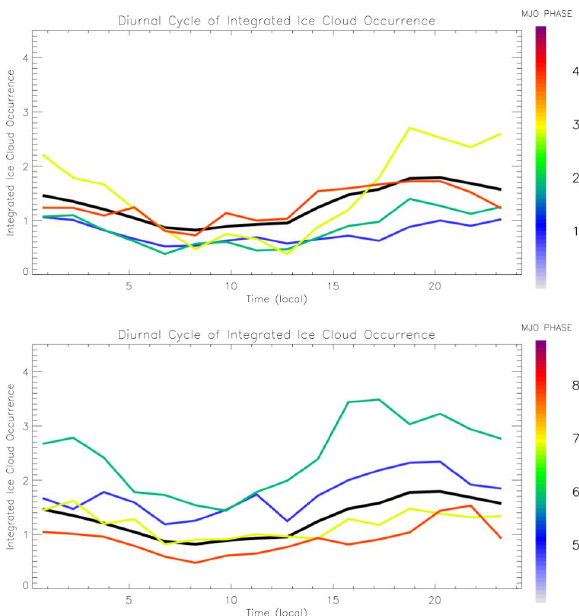
Figure 18: Same as Fig. 3 but for the MJO Phases: upper panel for Phases 1 to 4, lower panel for phases 5 to 8